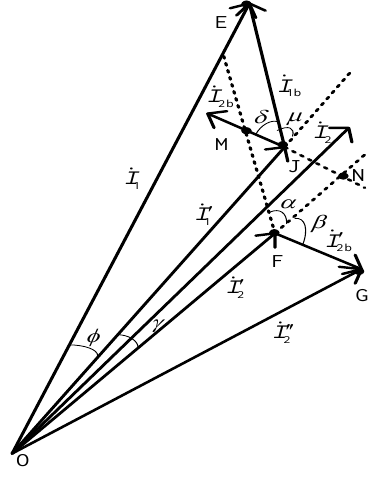
Figure 5. Phasor diagram of the influence of DVR on the adjacent load current.